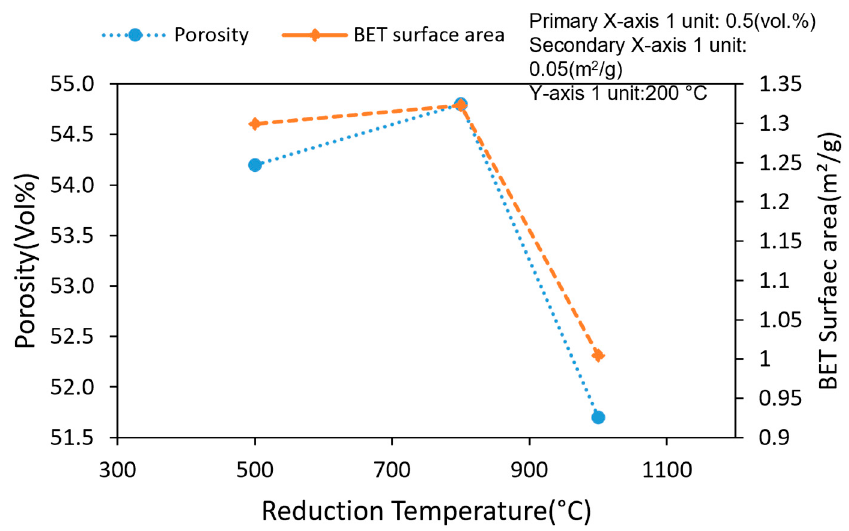
Figure 7. Porosity of reduced pellets at different reduction temperatures.